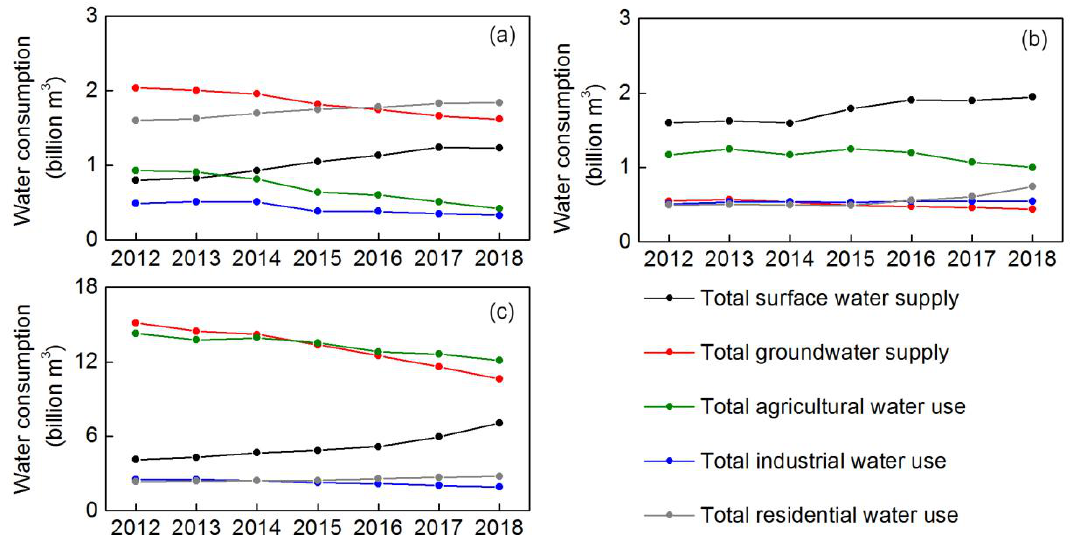
Figure 13. Water resources utilization in BTH from 2012 to 2018. ( a – c ) is Beijing, Tianjin and Hebei, respectively. Total surface water supply refers to the water intake of surface water engineering, which are water storage, water extraction and water diversion. Total groundwater supply refers to the exploitation of water wells. Total industrial water refers to the water used by industrial and mining enterprises in manufacturing, processing, cooling, air conditioning, purification, washing and other aspects in the production process. Total agricultural water use includes farmland irrigation water, forest and fruit land irrigation water, grassland irrigation water, fish-pond recharge water and livestock and poultry water. Total residential water use includes urban domestic water and rural domestic